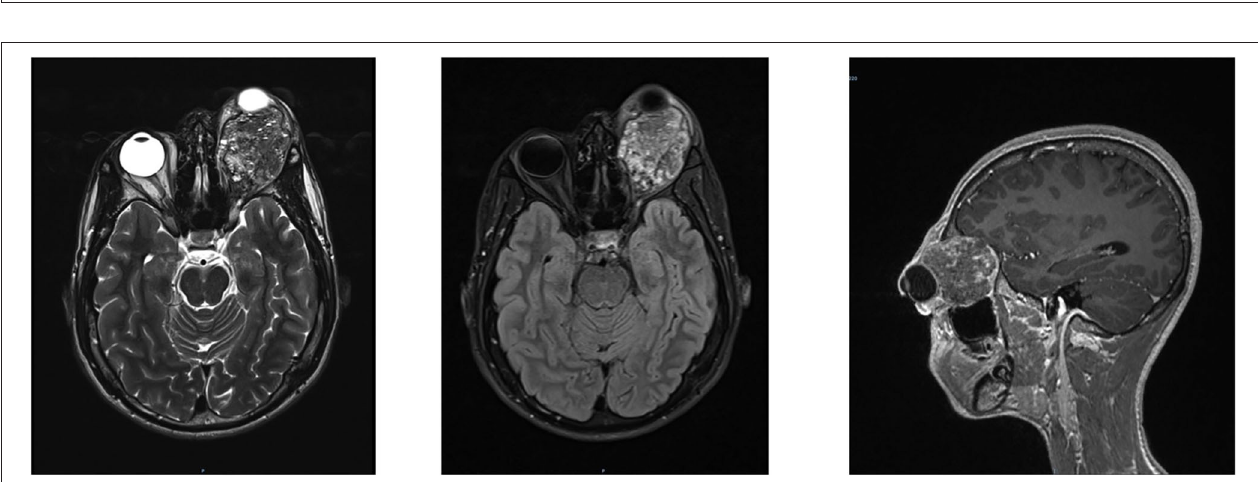
FIGURE 2 | Magnetic resonance imaging of brain and orbits, with T1- and T2-weighted sequences, showed the presence of a bulky pathological tissue located in the left retrobulbar intraorbital space, displacing anteriorly the eyeball and incorporating the optic nerve, which did not appear recognizable in all its intraorbital